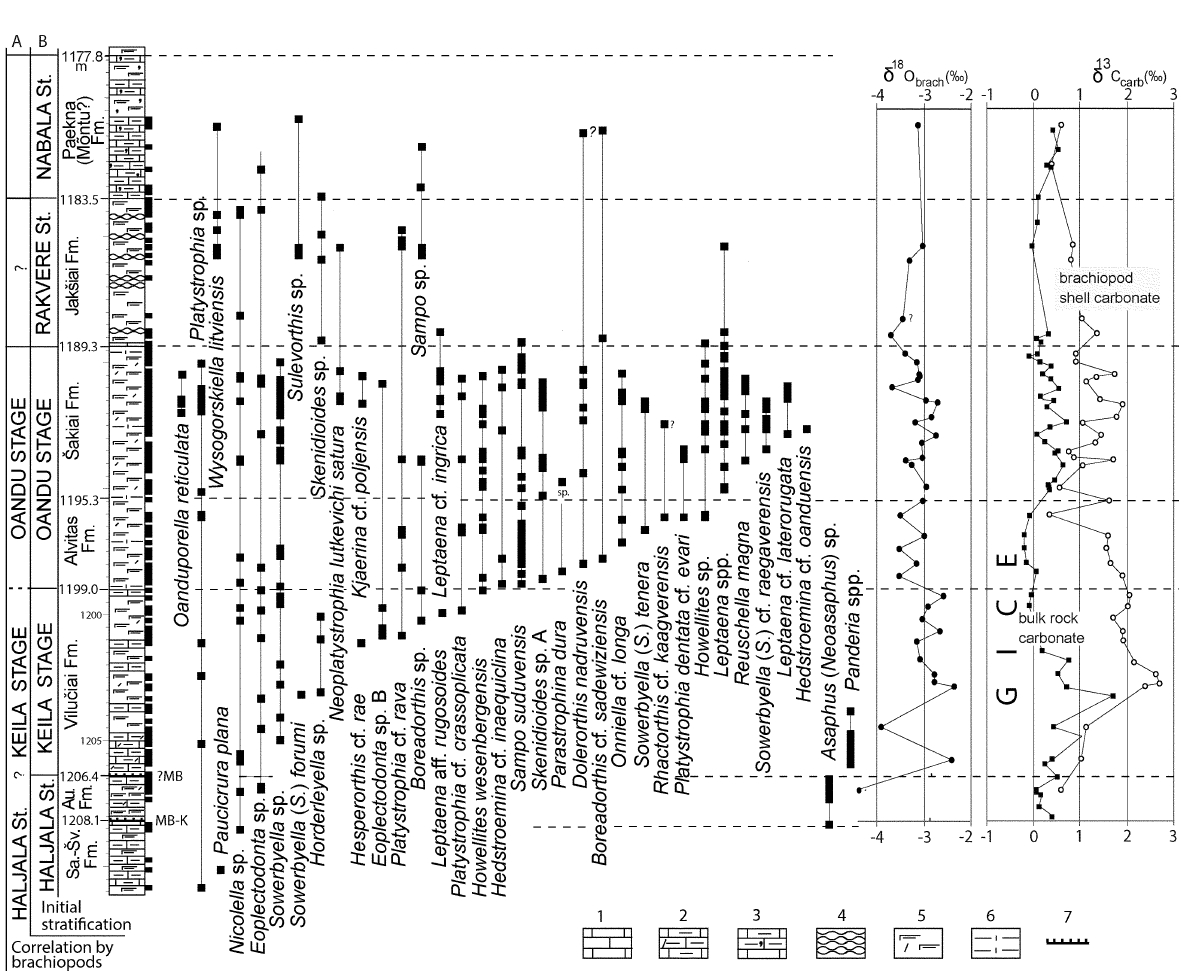
Fig. 3. Stratigraphy, lithology, distribution of brachiopods and isotope curves in the Pajevonys-13 core. S.-Š. Fm., Sartai-Šventupis Formation; Au. Fm., Auleliai Formation. Legend for the log: 1, limestone; 2, clayey limestone; 3, clayey limestone with glauconite; 4, bioclastic clayey nodular limestone; 5, clayey marl; 6, calcareous clay; 7, K-metabentonite (MB-K – Kinnekulle K-bentonite). On the left side of the log: A – correlation of the formation in terms of brachiopod data; B – age of the formation according to the stratigraphical chart of Lithuania (see Paškevi č ius